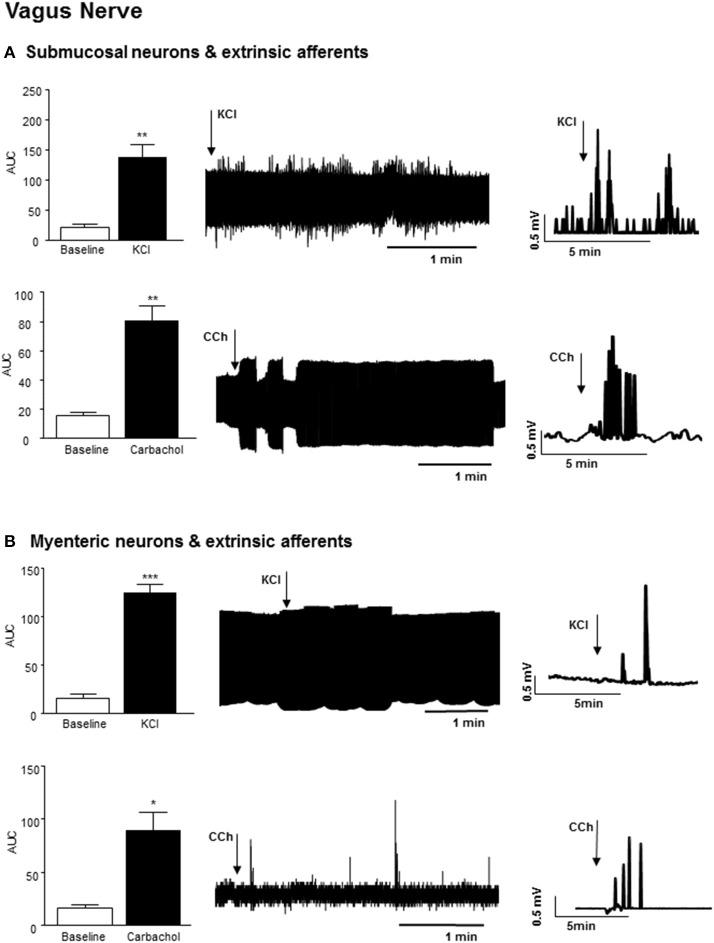
Vagal nerve activity evoked by neural stimulation in the distal colon. (A) The bar charts and sample filtered and unfiltered traces show increased nerve firing in the vagus nerve in response to exposure of submucosal neurons and the extrinsic afferents of the distal colon to KCl (75 mM, n = 3) and carbachol (CCh, 100 μM, n = 3). (B) The bar charts and representative traces shows increased vagal nerve firing in response to application of KCl (75 mM, n = 3) and carbachol (CCh, n = 3) to longitudinal muscle myenteric plexus preparation from the distal colon. *p < 0.05, **p < 0.01, and ***p < 0.001, respectively.